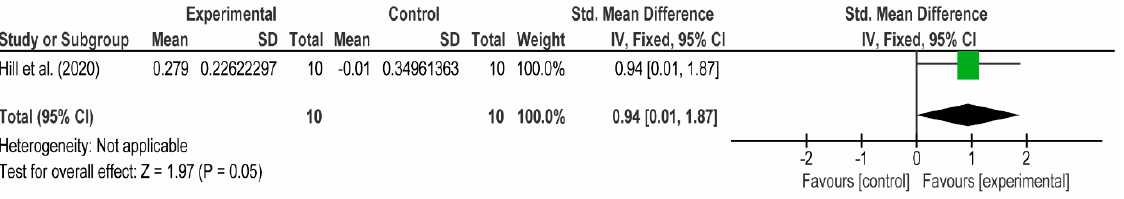
Figure 16. The effect size of 4- weeks of concentric low-load (at 30% of concentric elbow flexion peak torque) forearm flexion-extension training on increasing the biceps brachii MT.